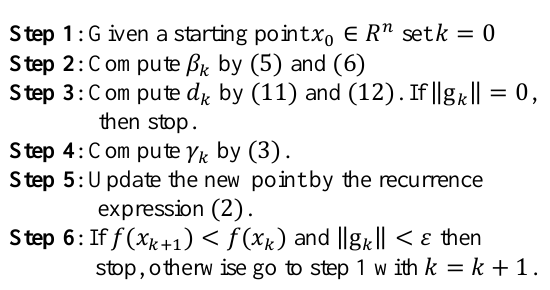
Algorithm 1.1 (Spectral CG